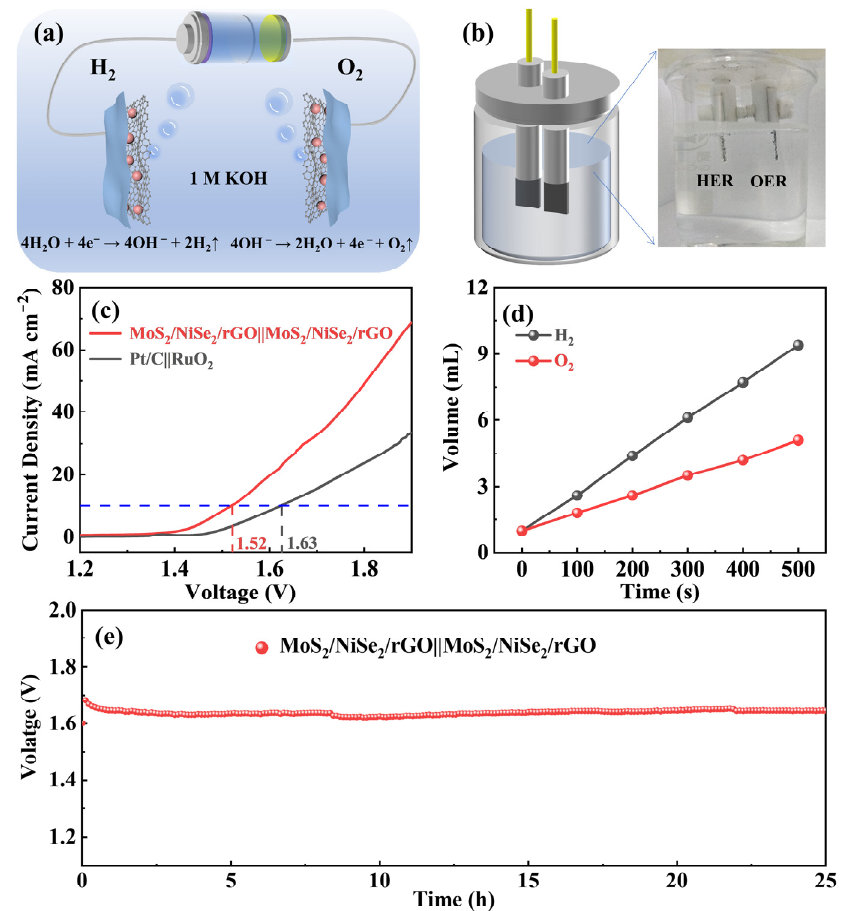
Figure 5. Overall water splitting performance of MoS 2 /NiSe 2 /rGO in 1.0 M KOH solution. ( a ) Schematic diagram of overall water splitting. ( b ) Double-electrode device for overall water splitting. ( c ) LSV curves of the MoS 2 /NiSe 2 /rGO||MoS 2 /NiSe 2 /rGO and Pt/C||RuO 2 catalysts. Inset: A photo of the overall water splitting cell. ( d ) The production of H 2 and O 2 as a function of time. ( e ) Time-dependent current density curve of MoS 2 /NiSe 2 /rGO||MoS 2 /NiSe 2 /rGO for 25 h.